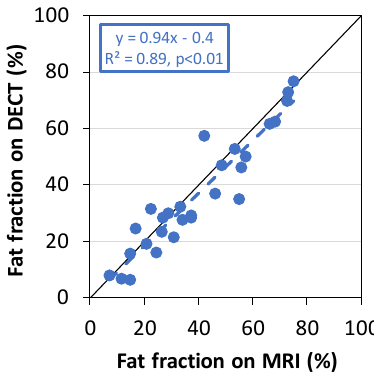
Figure 3. The fat fraction measured by DECT plotted against the fat fraction measured by MRI in the fibroglandular tissue of the normal-side breast.